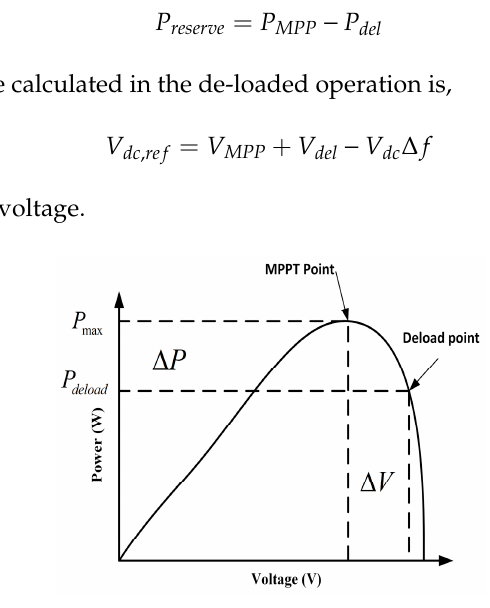
Figure 18. Frequency response in power system network.